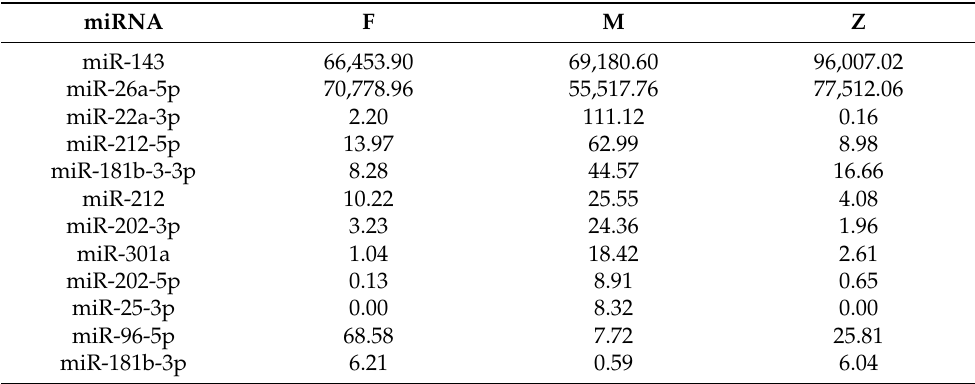
Table 4. The expression level of differential miRNAs related to gonadal development.